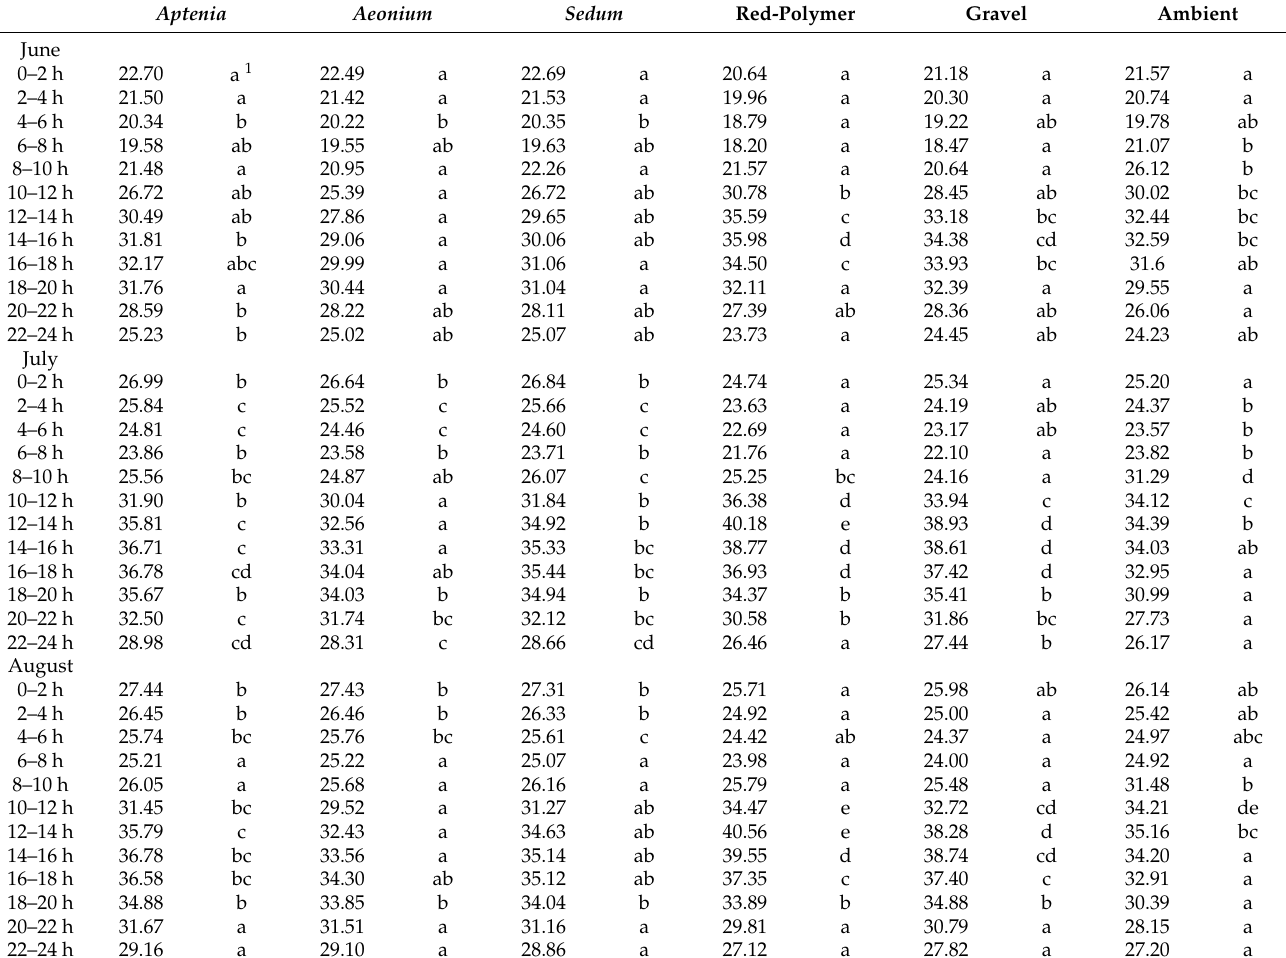
Table 5. Average temperatures ( ◦ C) every 2 h-periods during the day ( n = 5 days) in